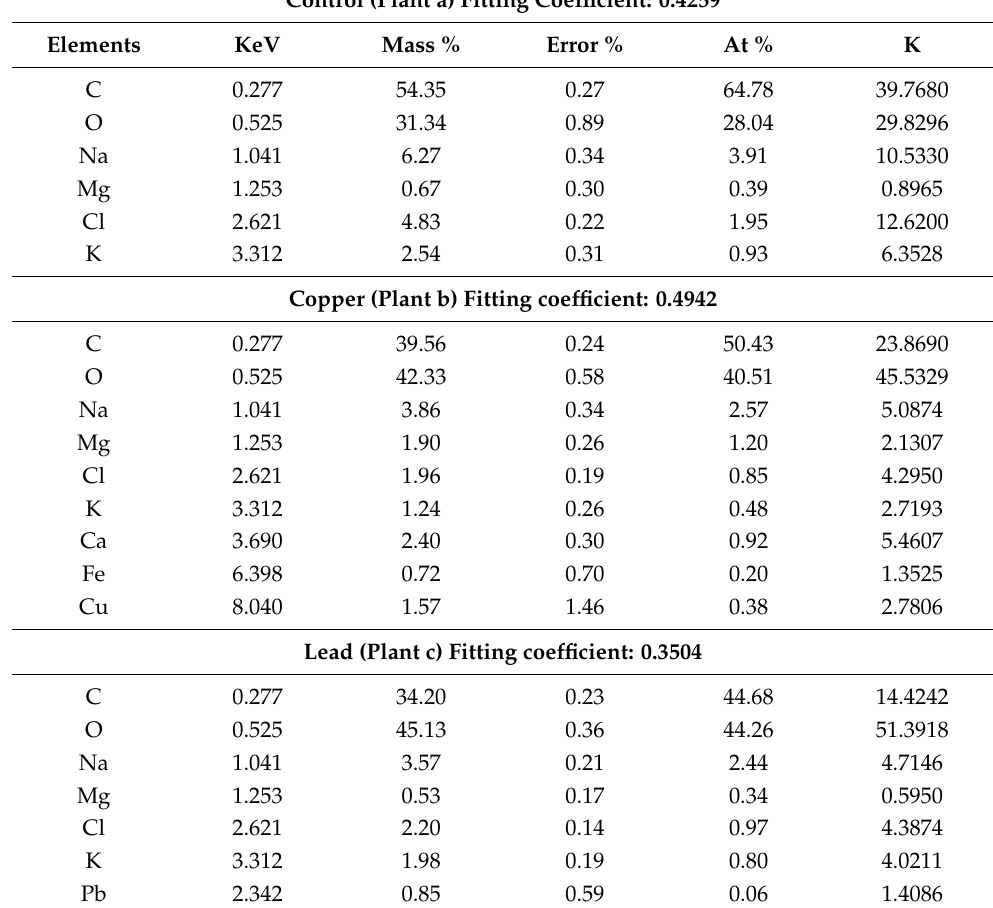
Table 2. EDS elemental analysis of S. oleracea for control leaf plant “a”, Copper stress leaf plant “b”, and Lead stress leaf plant